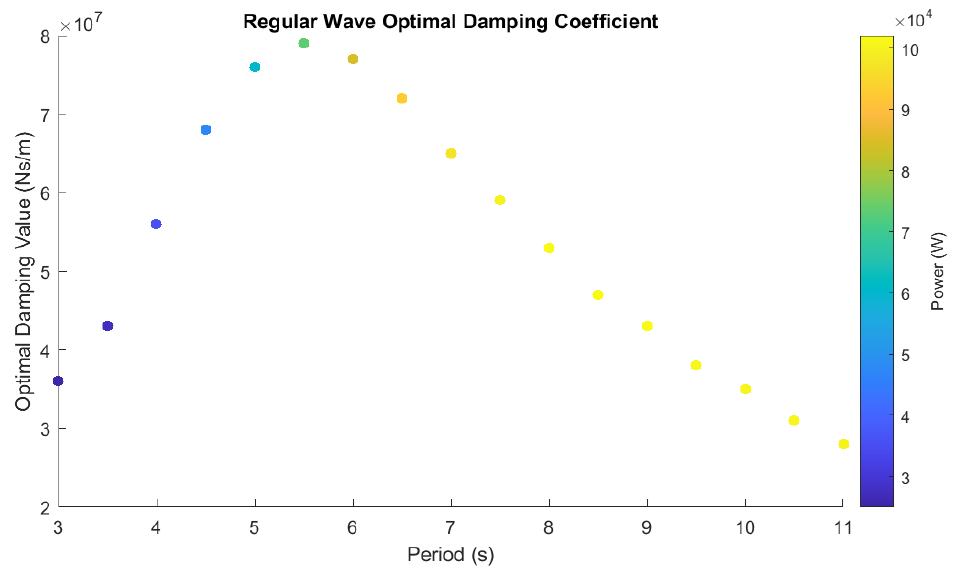
Figure 2. Optimized damping coefficient for each Peak spectral wave